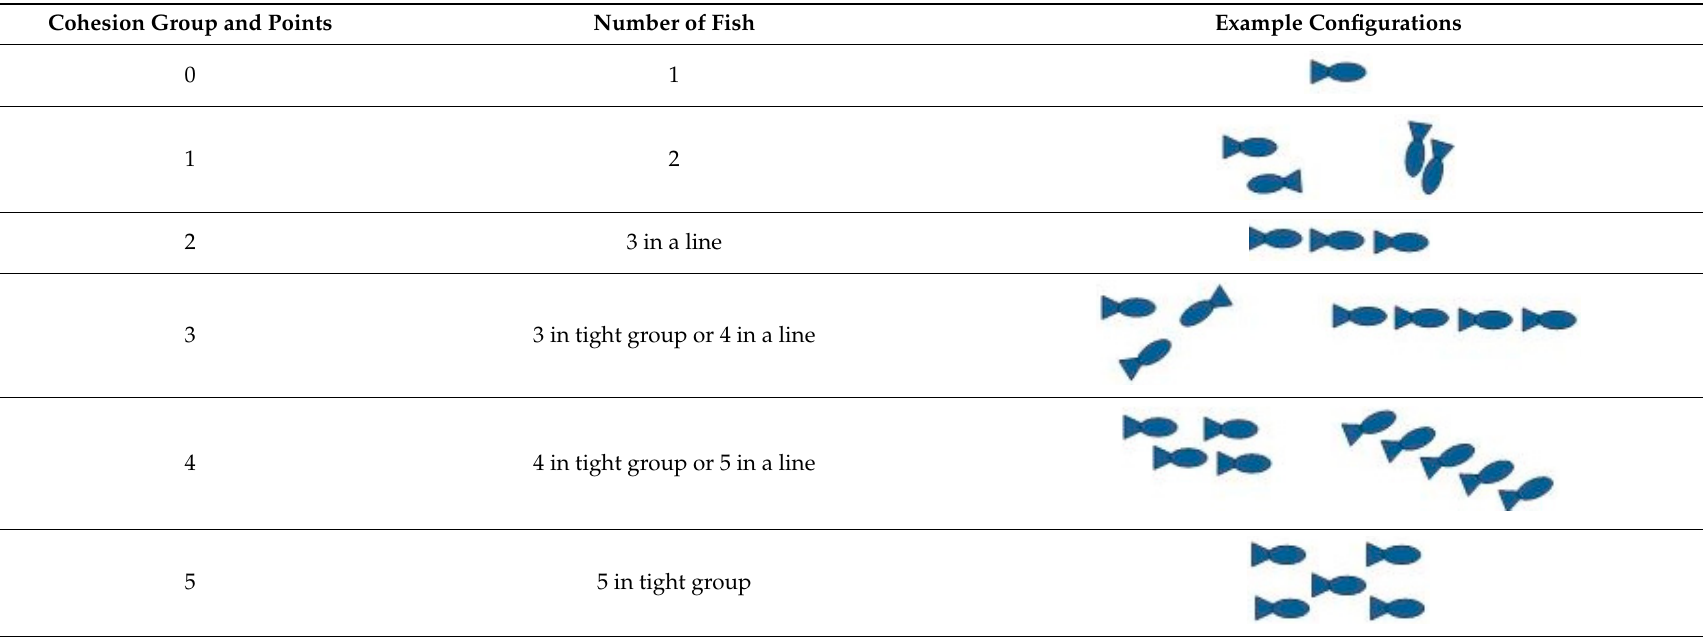
Table 1. Rules and examples for cohesion scoring based on number and formation of fishes in the